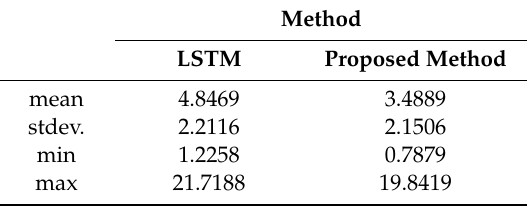
LSTM Proposed Method Figure 8. Daily MAPE of the LSTM and the proposed methods for the 250 weekdays in the testing data. Table 3. Statistics of the daily MAPE for the 250 weekdays in the testing data.